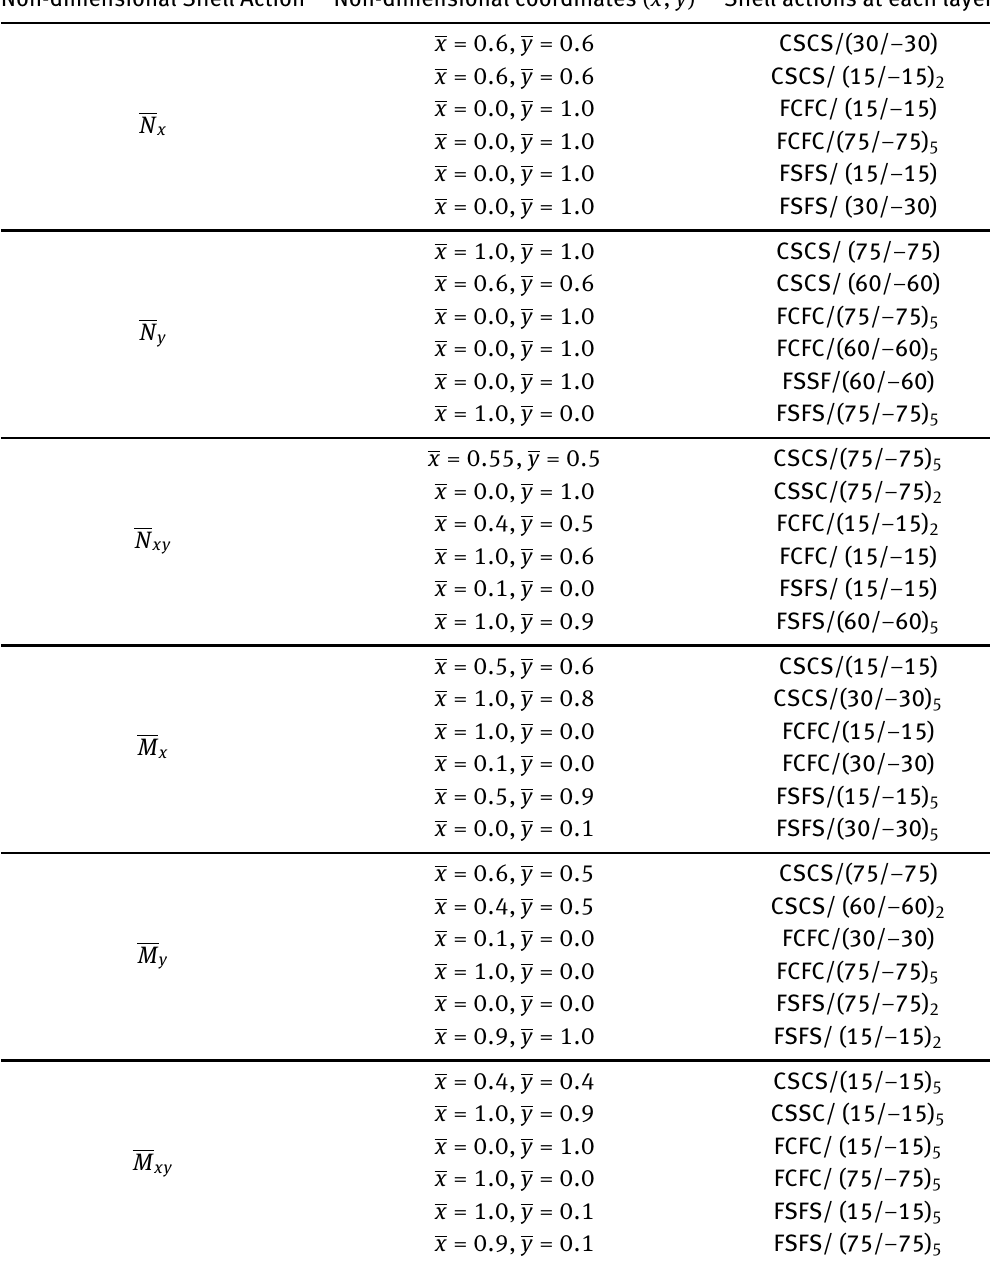
Table 16: Shell options arranged according to ascending order of positive values of shell actions different antisym- metric angle ply lamination and boundary conditions of stiffened composite hypar shell with